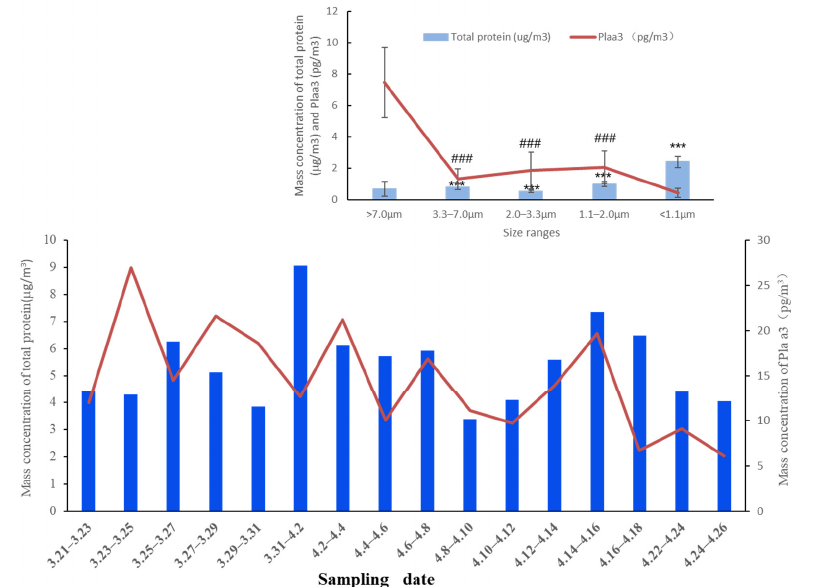
Figure 2. Mass concentration of total protein and Pla a3 from 21 March to 26 April 2017. (Total pro- tein in the PM with size range 3.3–7.0 μ m vs. <1.1 μ m, 2.0–3.3 μ m vs. <1.1 μ m, and 1.1–2.0 μ m vs. <1.1 μ m; n = 5, ### p < 0.001; Pla a3 in the PM with size range >7 μ m vs. 3.3–7.0 μ m; >7 μ m vs. 2.0–3.3 μ m; >7 μ m vs. 1.1–2.0 μ m; >7 μ m vs. <1.1 μ m, n = 5, *** p < 0.001).